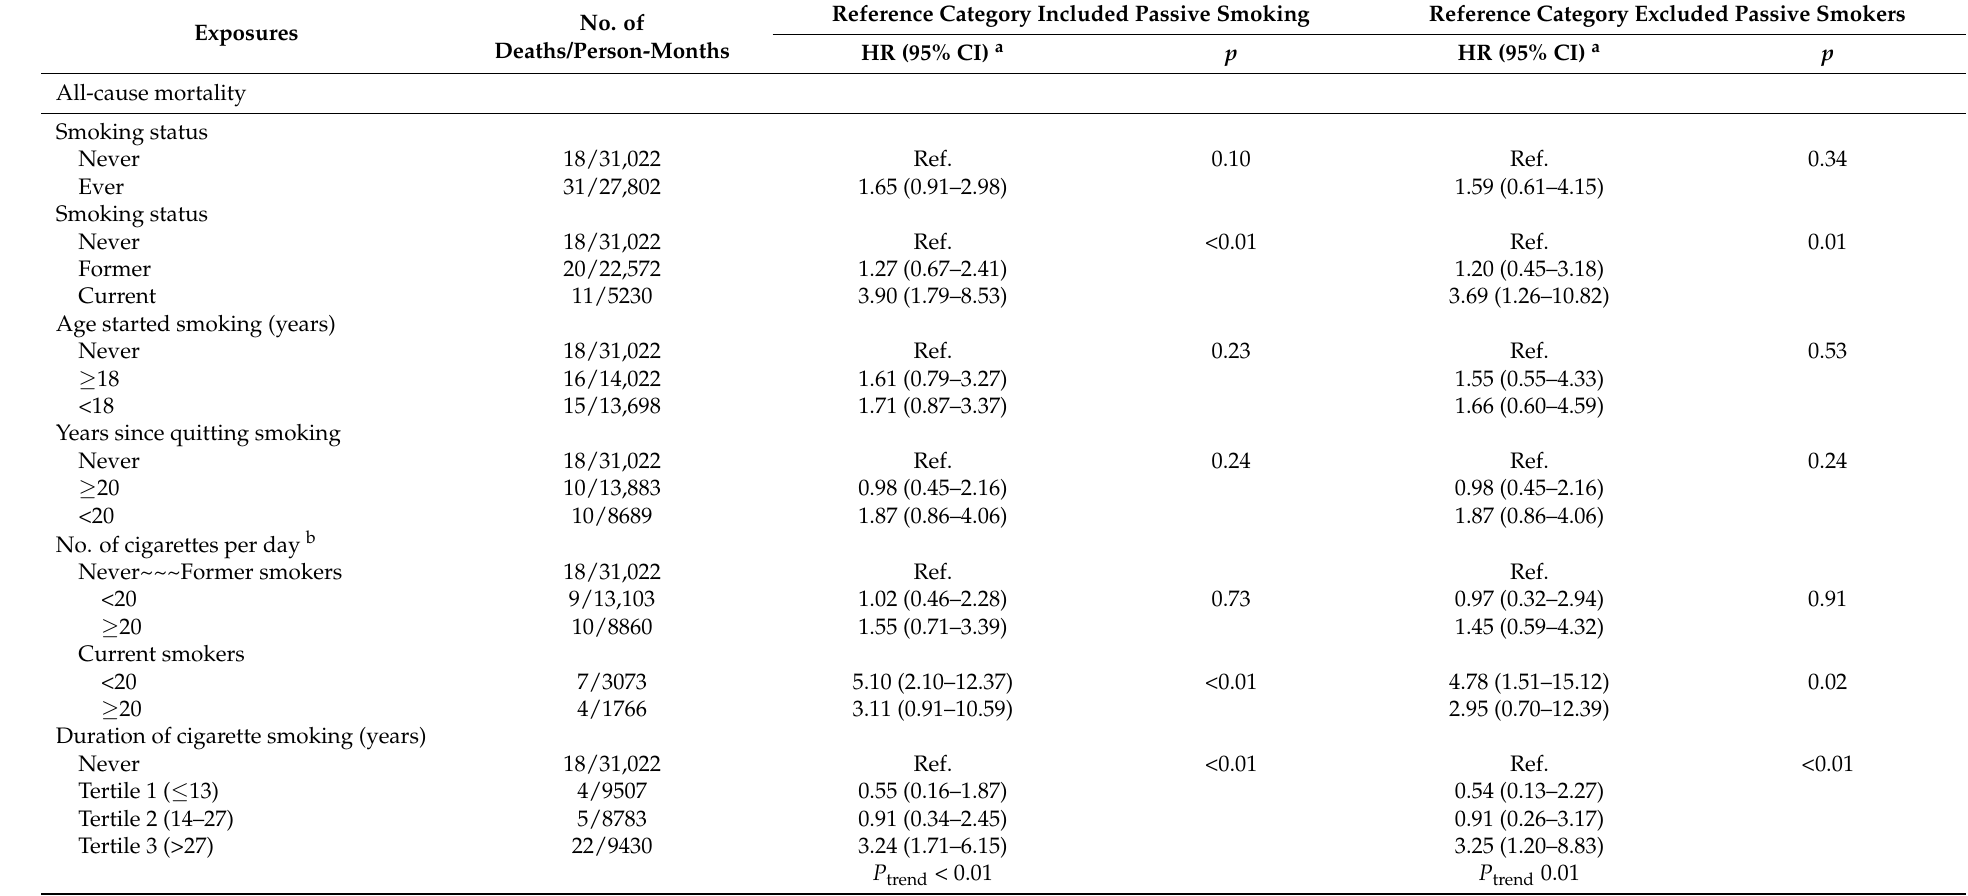
Table 5. Hazard ratios and 95% confidence intervals for all-cause mortality and FL-specific mortality in relation to